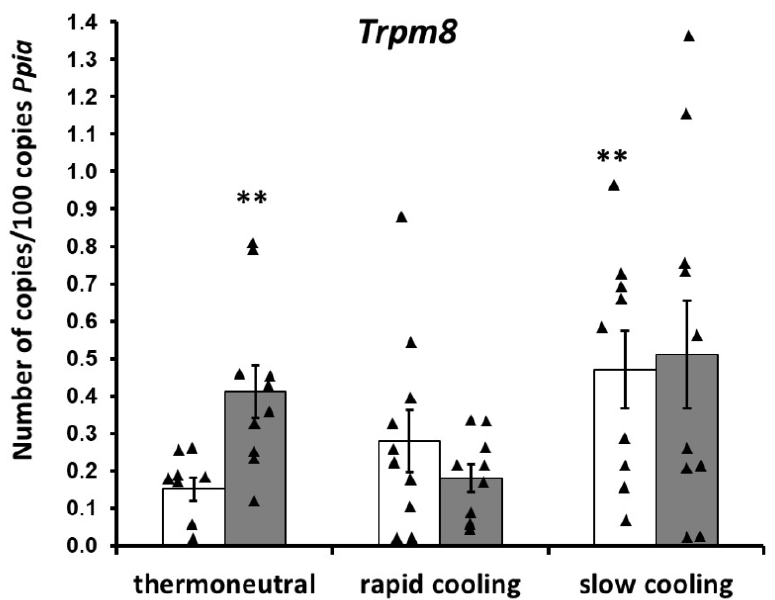
Figure 3. Effect of the peripheral ion channel TRPM8 activation on mRNA expression of the Trpm8 gene in the anterior hypothalamus of hypertensive rats. Pharmacological activation of the TRPM8 ion channel: application of a 1% menthol suspension. Thermal activation of the TRPM8 ion channel: cooling (rapid or slow). ** p < 0.02: a significant difference from the control (application of saline) under thermoneutral conditions (under thermoneutral conditions for comparison saline-menthol p = 0.007, t = 3.08; between control (saline) under thermoneutral conditions and saline after slow cooling p = 0.013, t = 2.79; between control (saline) under thermoneutral conditions and saline after rapid cooling p = 0.207, t = 1.32; between saline and menthol after rapid cooling p = 0.305, t = 1.06; between saline and menthol after slow cooling p = 0.831, t = 0.216). Triangles represent the individual values. Open bars—application of saline; filled bars—application of a 1% menthol suspension.